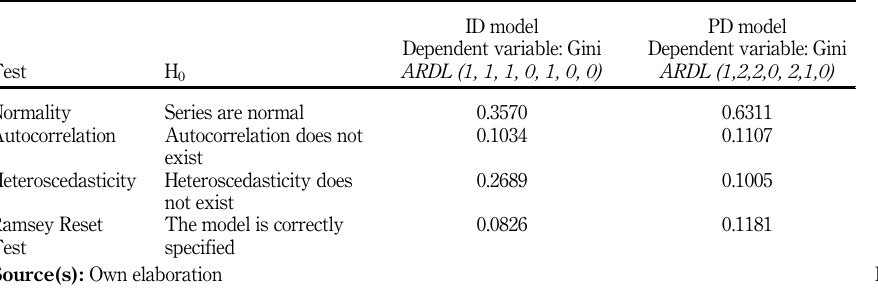
Table 4. Diagnostic test